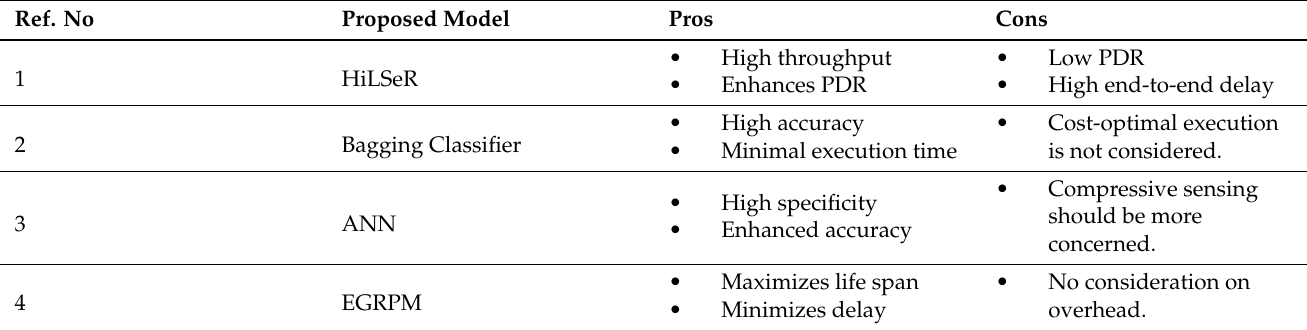
Table 2. Review of conventional IoT